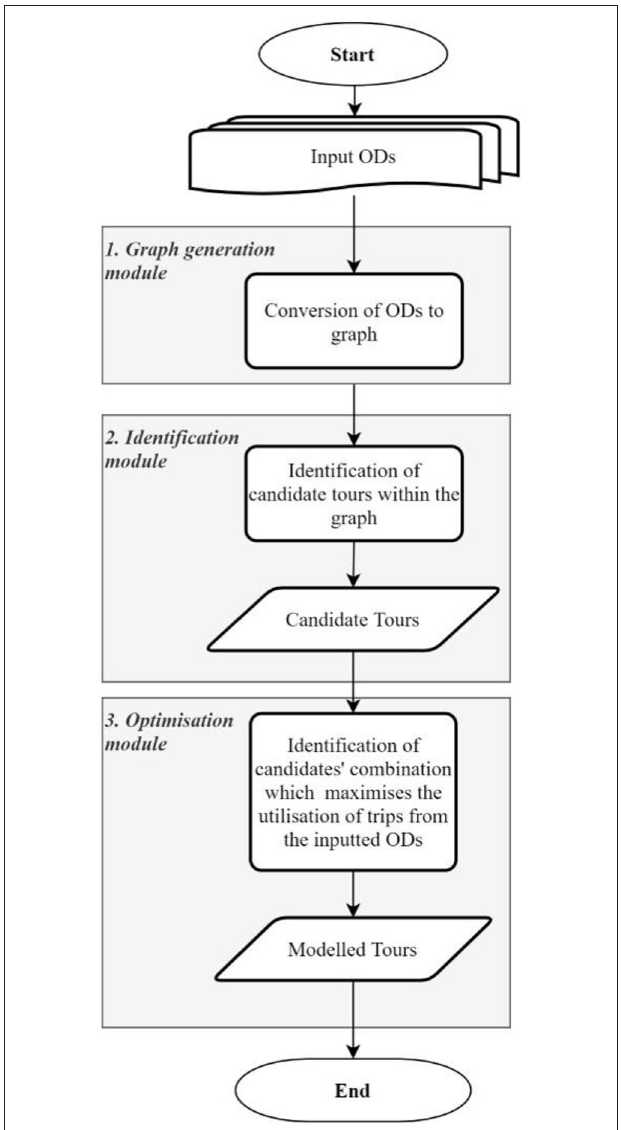
FIGURE 1 | Flowchart of the suggested